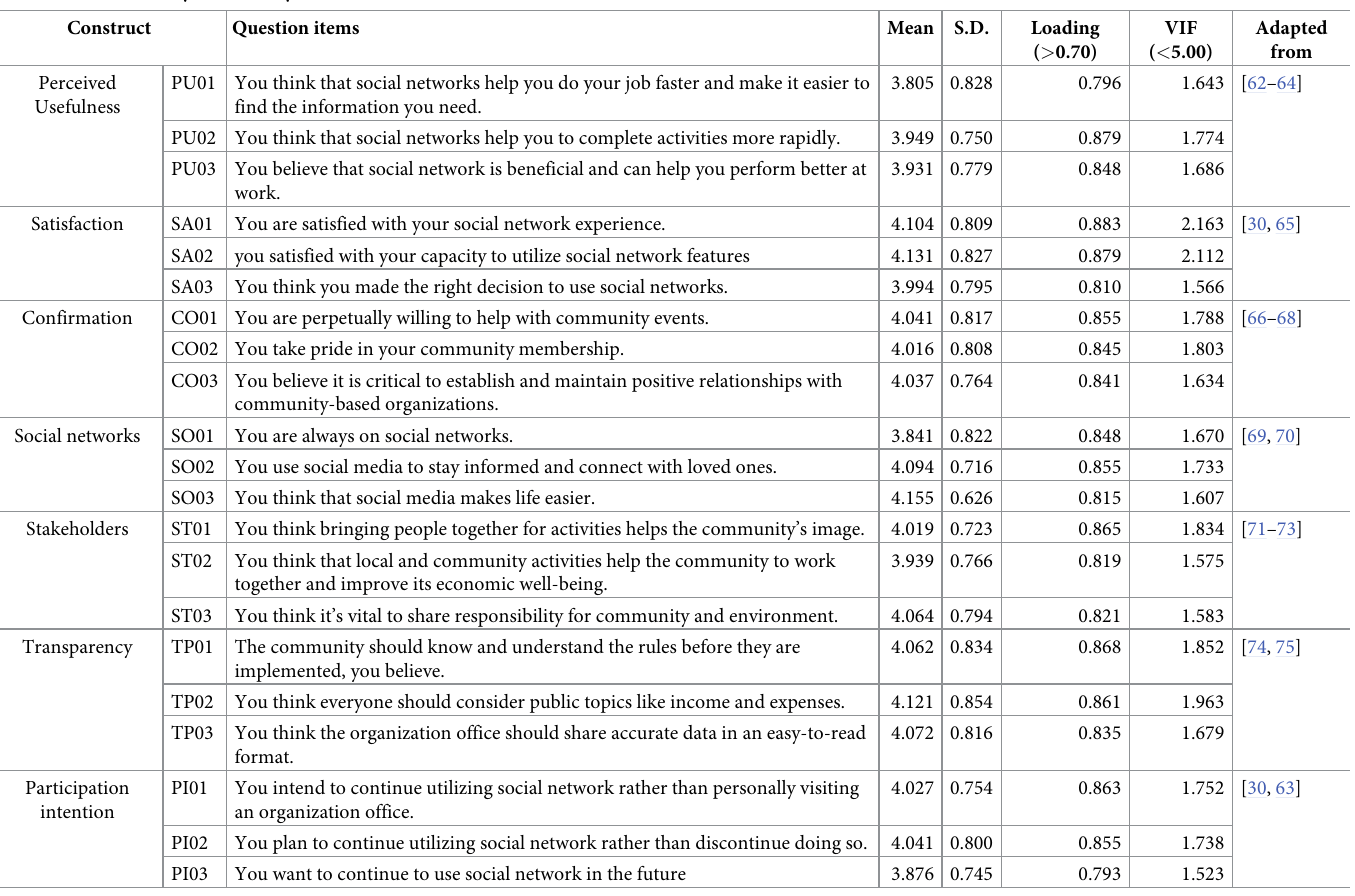
Table 5. HTMT refers to the sum of all cross-variable correlations among indicators. As Table 3. The reliability and validity of the